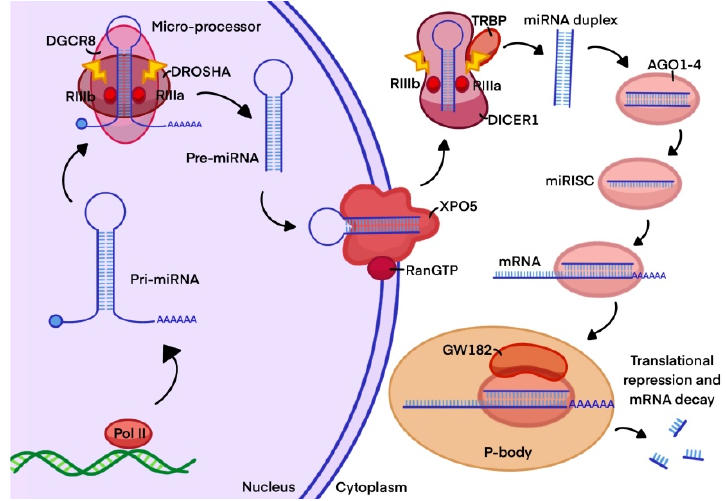
Figure 6. Biogenesis of miRNAs. miRNAs are transcribed as hairpin pri-miRNAs (1000 nt) by the RNA polymerases II and III. Drosha processes pri-miRNAs into shorter pre-miRNAs (60–120 nt). This stem-loop RNA is exported to the cytoplasm by exportin 5 and Ran-GTPase. Then, the pre-miRNA is processed by Dicer into a short double-strand RNA molecule, which is recruited by the RISC complex to select one of the strands to interact with the protein Argonaute (Ago), to exert its function by targeting the 3 ′ UTR target mRNA.